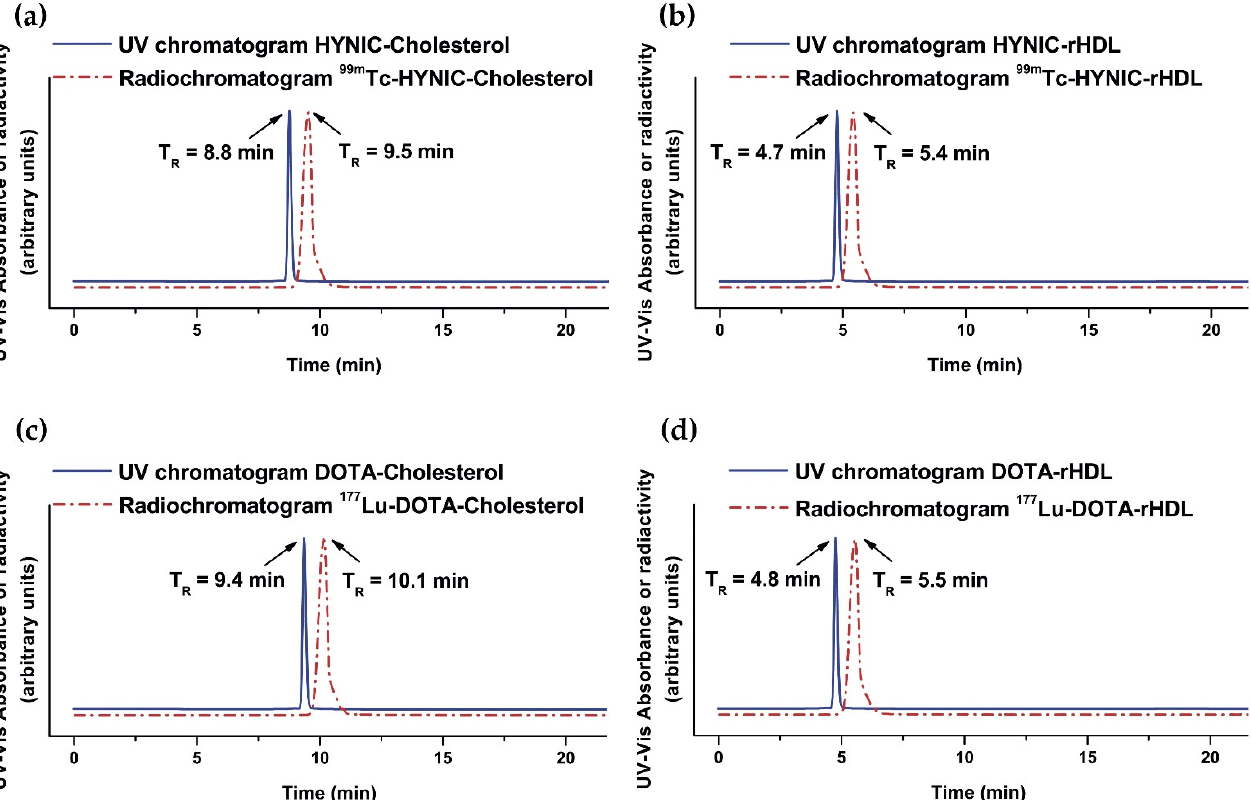
Figure 4. Size-exclusion HPLC chromatogram (254 nm; blue continuous line) of ( a ) HYNIC-Cholesterol, ( b ) HYNIC-rHDL nanoparticles, ( c ) DOTA-Cholesterol, and ( d ) DOTA-rHDL nanoparticles. Size-exclusion HPLC radiochromatogram (red dotted line) of ( a ) 99m Tc-HYNIC-Cholesterol, ( b ) 99m Tc-HYNIC-rHDL nanoparticles, ( c ) 177 Lu-DOTA-Cholesterol, and ( d ) 177 Lu-DOTA-rHDL nanoparticles. Protein-Pak 300SW column, 0.1 M phosphate buffer (pH 7.4), flow rate 1.0 mL/min.